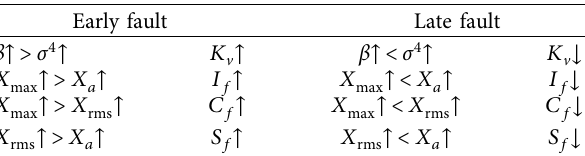
Figure 9: Effect of defect width on characteristic parameters under different working speeds. (a) Effective value. (b) Square root amplitude. (c) Absolute mean value. (d) Peak value. (e) Kurtosis factor. (f) Pulse factor. (g) Peak factor. (h) Shape factor. Table 4: Relative growth speed of characteristic parameters in different